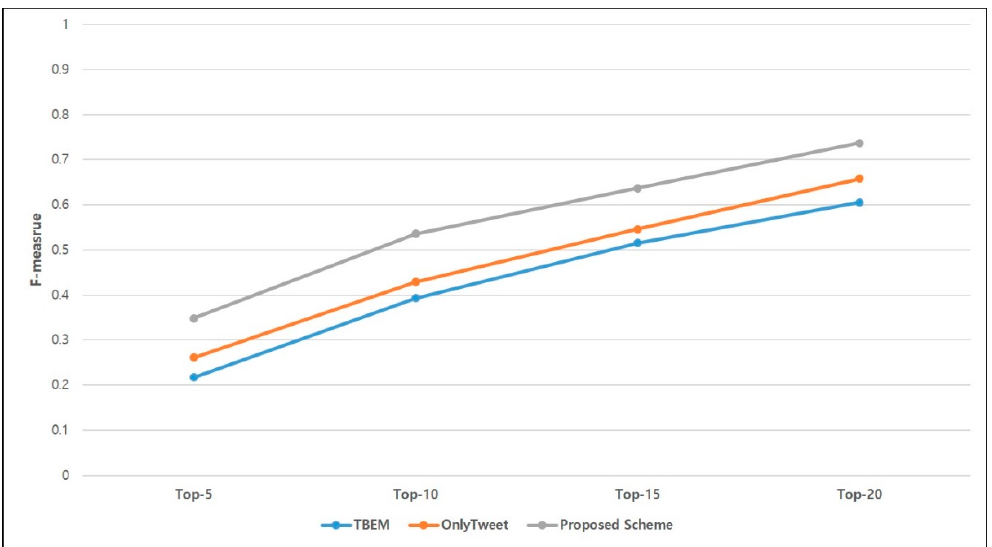
Figure 11. F-measure according to the number of top-k events.